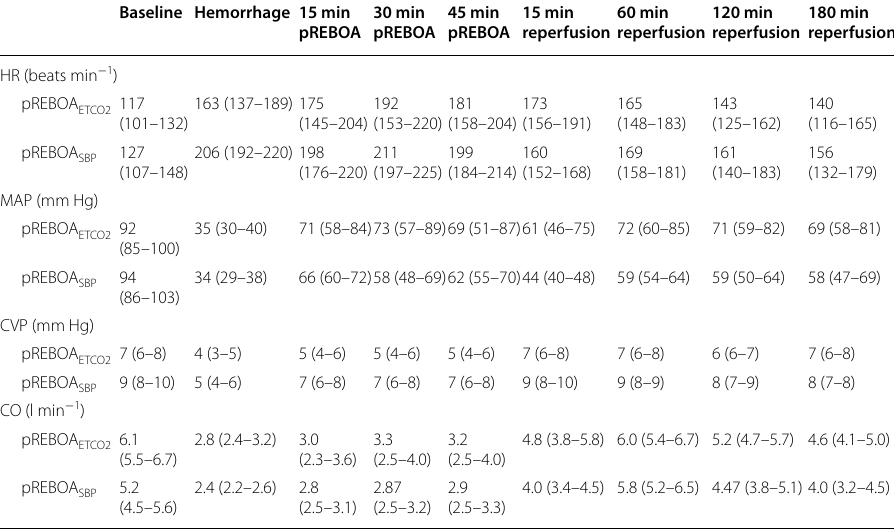
Hemodynamics during end-tidal carbon dioxide (ETCO 2 ) targeted partial resuscitative endovascular balloon occlusion of the aorta (pREBOA, pREBOA ETCO2 , n 10) and proximal systolic blood pressure targeted pREBOA (pREBOA SBP , n = anesthetized, mechanically ventilated pigs. Data are means (95% confidence intervals) HR: heart rate; MAP: mean arterial pressure; CVP: central venous pressure; CO: cardiac